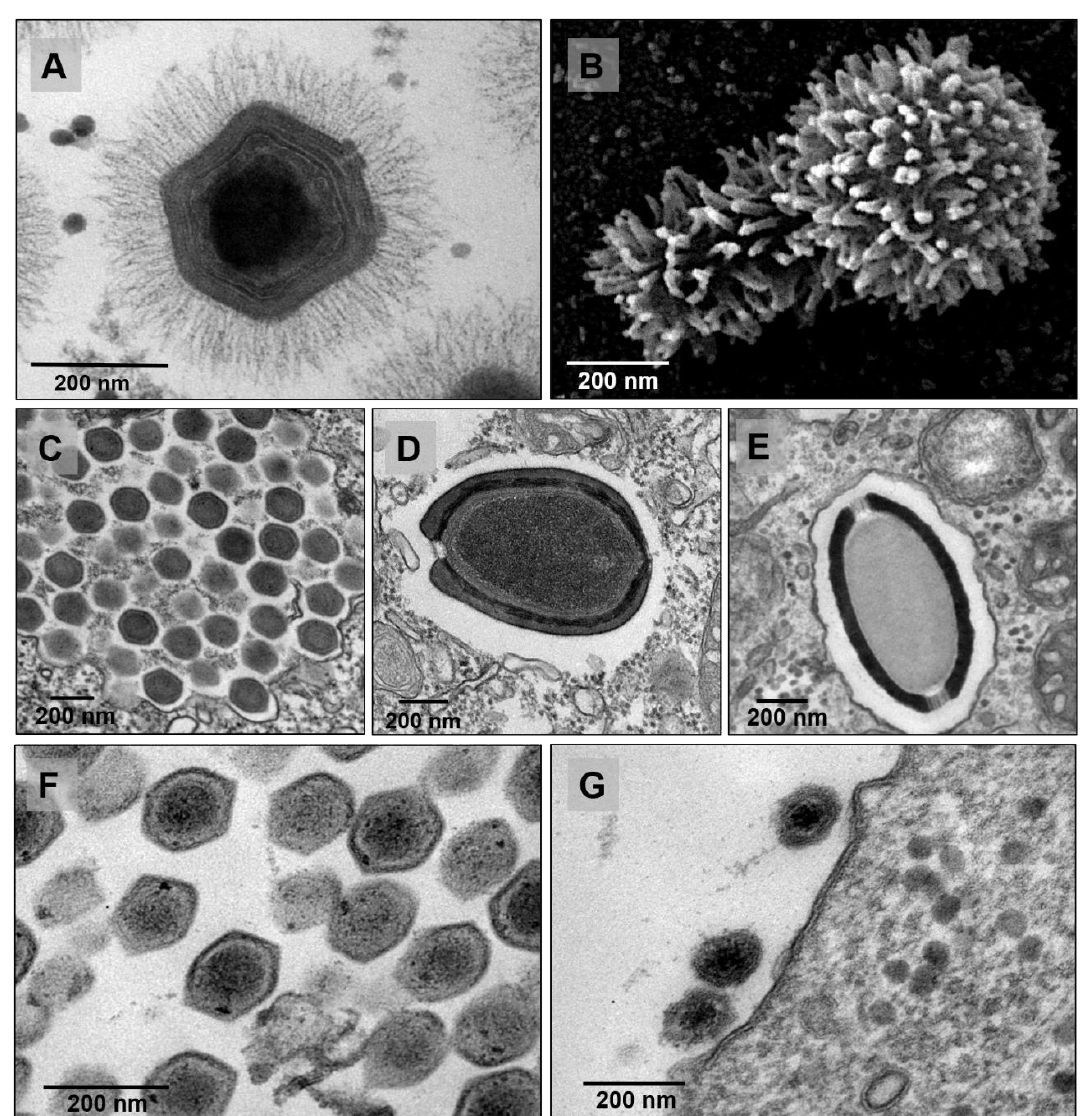
Figure 2. Panel with TEM images for the major groups of amoebal viruses isolated in Brazil. ( A ) mimi-virus, ( B ) tupan-virus (source: 10.1038/s41598-018-36552-4), ( C ) marseille-virus, ( D ) pandora-virus, ( E ) cedrat-virus, ( F ) fausto-virus, and ( G ) yara-virus. The genomes of the tupanviruses are complex and composed of double-stranded DNA of 1.44–1.51 Mb, encoding 1276–1425 predicted proteins (Table 1) [10]. Phylogenetic